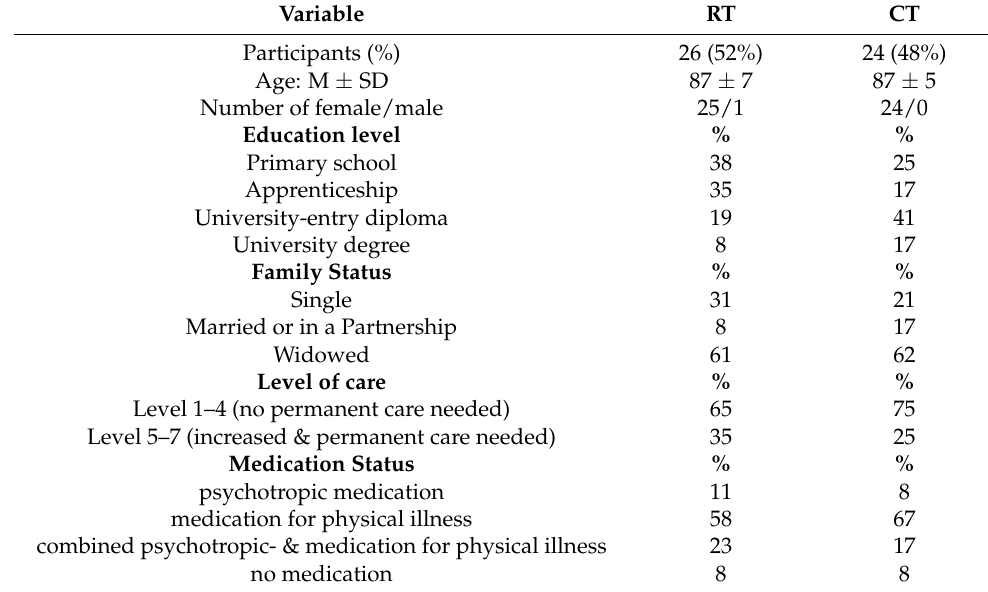
Table 1. Comparison of participant’s sociodemographic and clinical data in both